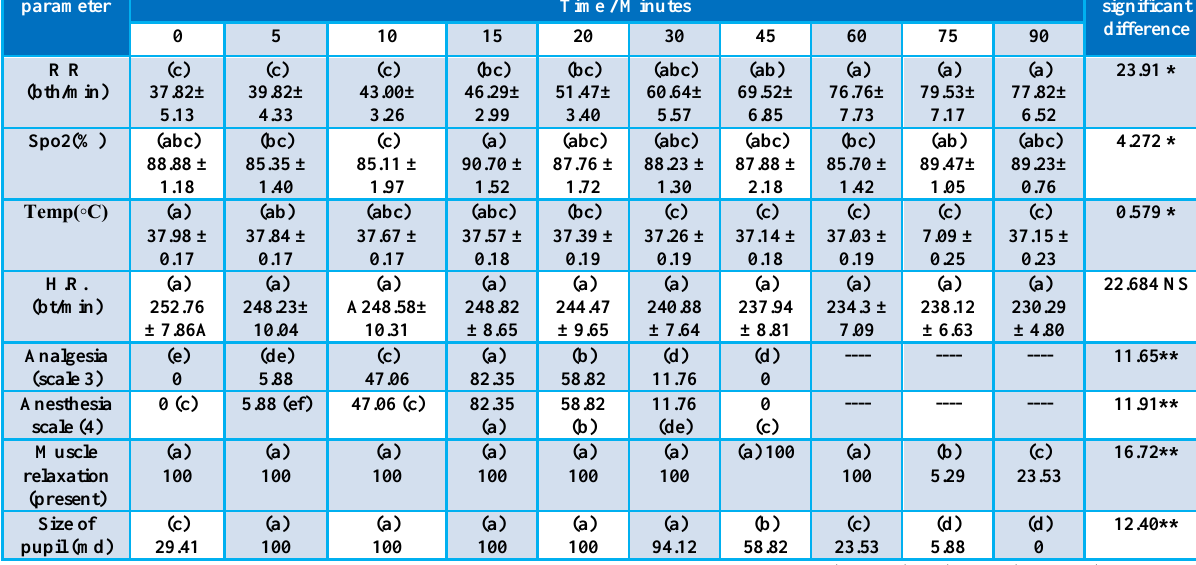
Table, 2: The effect of protocol (diazepam, propofol, and ketamine) on different parameters at ten time points. parameter Time /